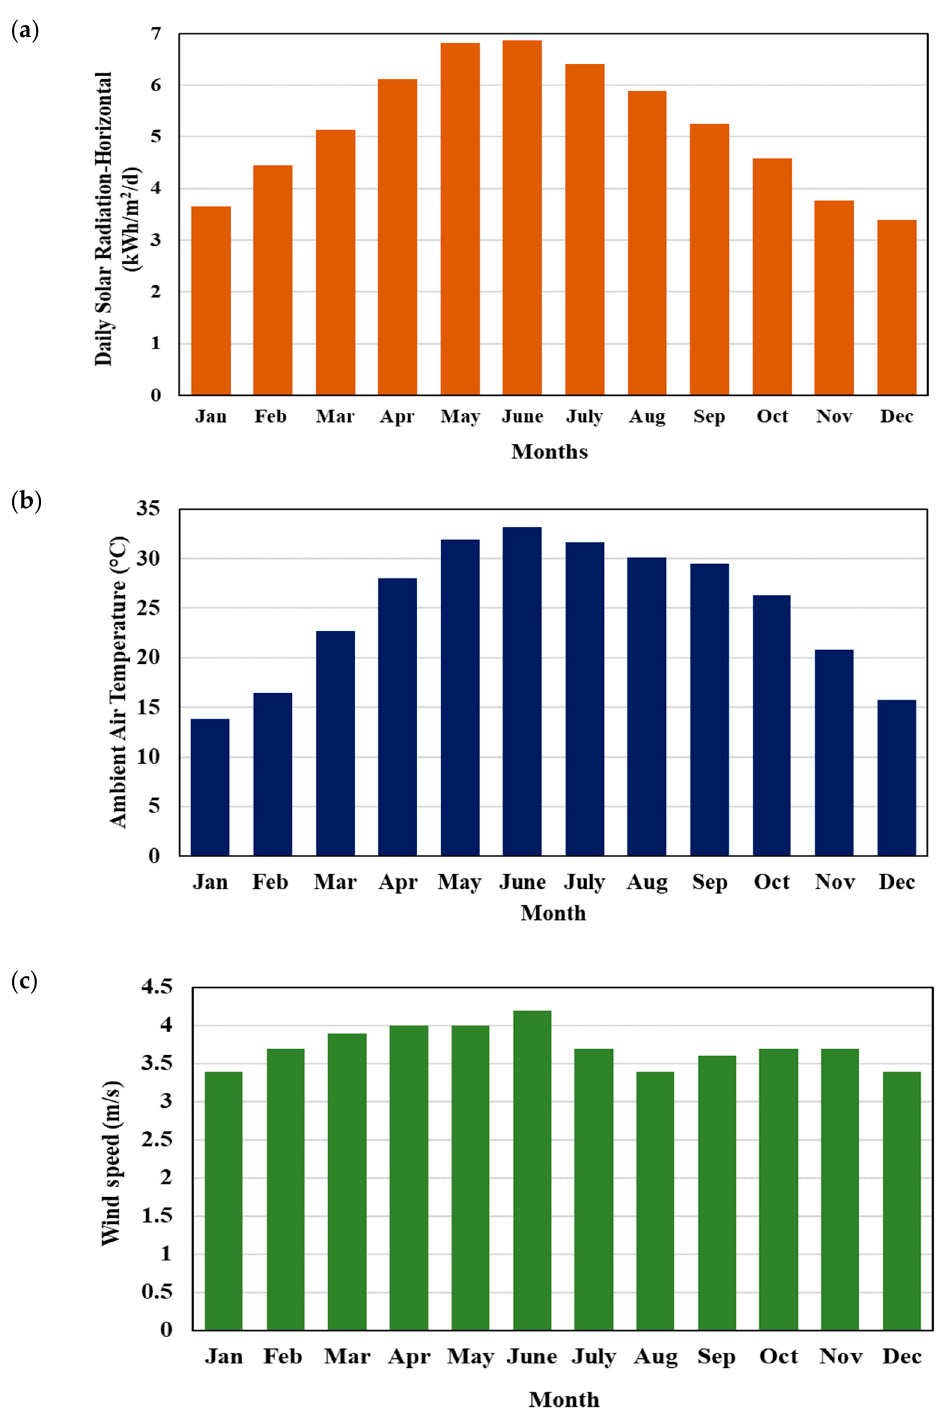
Figure 1. Monthly data for ( a ) daily solar radiation—horizontal, ( b ) ambient air temperature, and ( c ) wind speed [55].